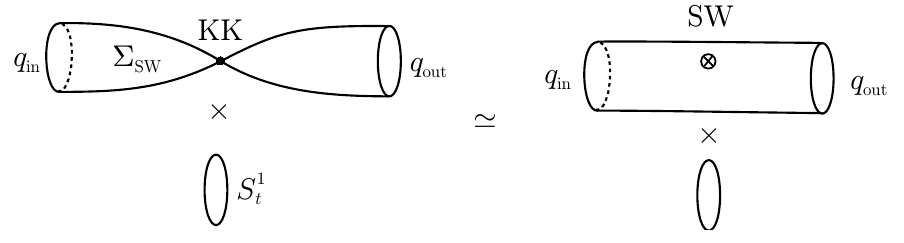
Figure 4 . The brane realization of N = 4 3d SQED in type IIB string theory.